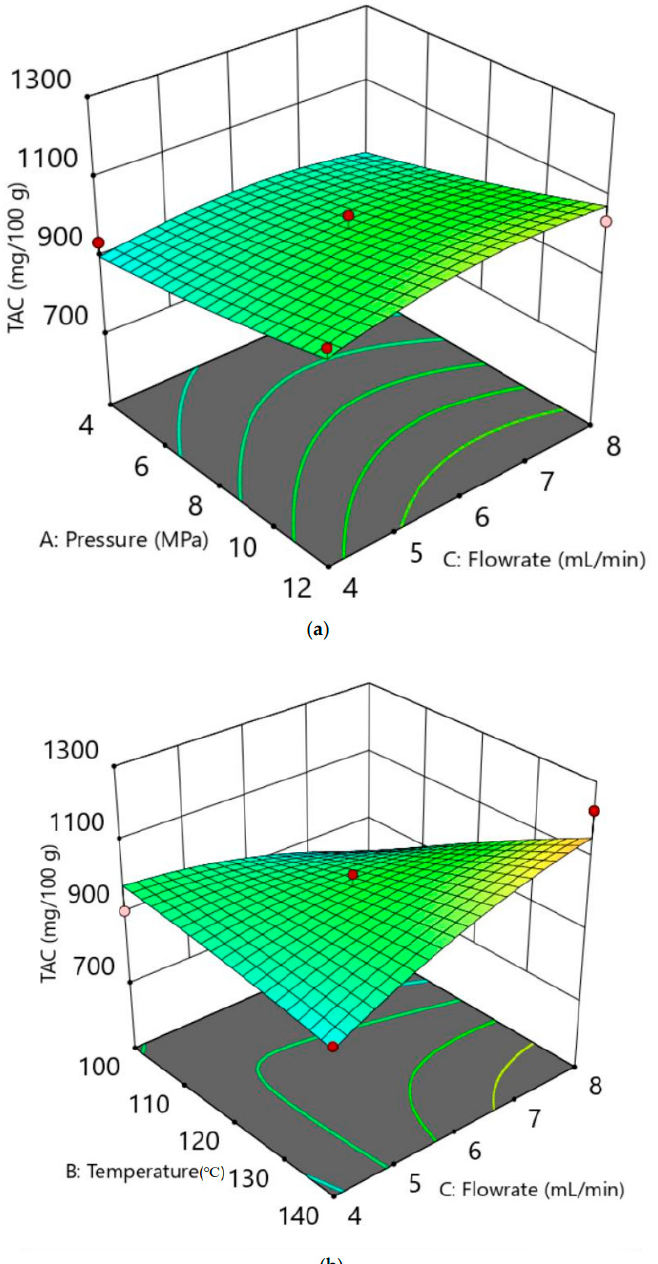
Figure 7. 3D response of the effect of SWE’s variable on TAC, mg/100 g ( a ) effect of pressure and flow rate at constant temperature; ( b ) effect of temperature and flow rate at constant pressure